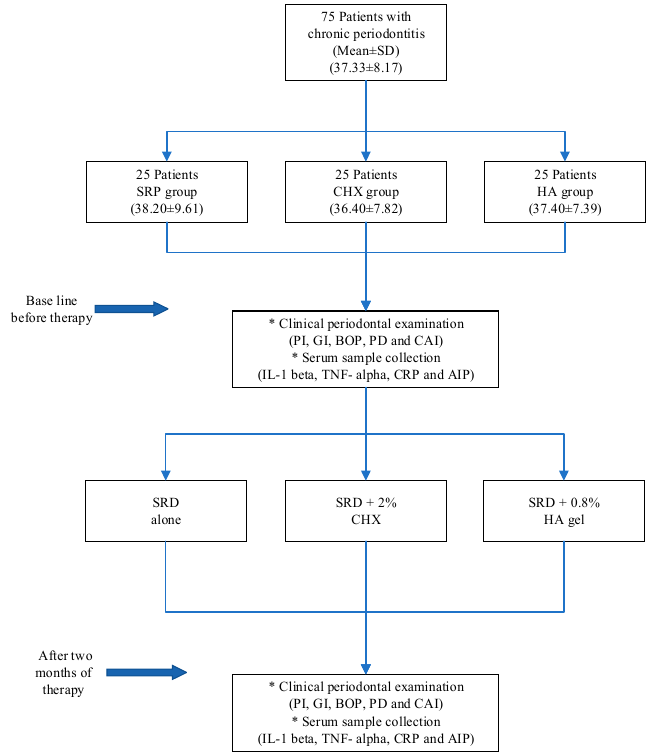
Figure 1. Flowchart of the study protocol. * Indicate the two main tasks of the research, the clinical periodontal parameters measurments and serum sample collection.